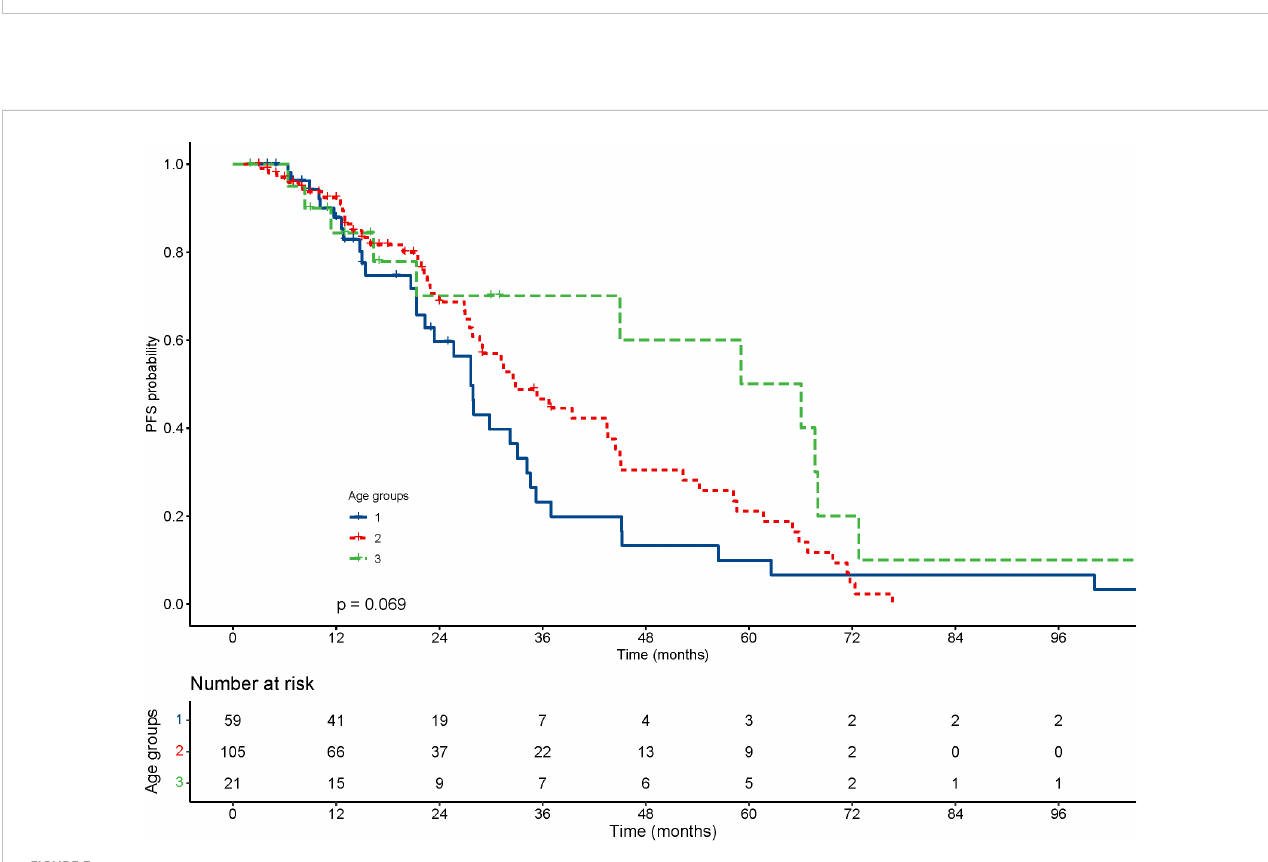
FIGURE 3 Kaplan – Meier curves for progression-free survival (PFS) of patients with small hepatocellular carcinomas after cryoablation. The log-rank test showed no signi fi cant difference between the four groups (P =0.069).